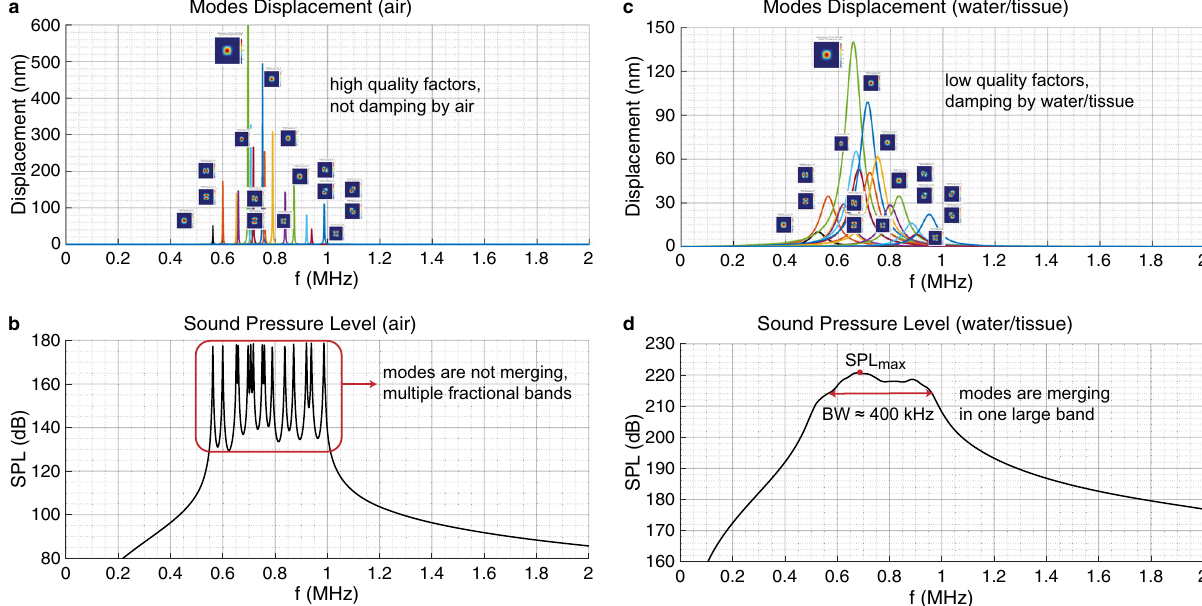
Fig. 7 Modes merging in air vs water/tissue. a LN pMUT 3D membrane displacement measurement and peak detection in air. Modes are matched to COMSOL Multiphysics simulation based on their shape. Here we notice that the peaks are separated from each other due to a high-quality factor in air. The different colors represent different modes extracted from the measurement in air from Fig. 2a. b Simulated combined sound pressure level (SPL) of the device in air. Here we can notice that the different peaks are not merging, instead we have the formation of multiple fractional bands. c Displacement modeling of the resonance peaks under the damping effect of the water and tissue medium. Here the quality factor is getting lower and closer to one another. The different colors represent different modes extracted from the measurement in air from Fig. 2a and then modeled under the damping effect of the water, by decreasing the quality factor. d Modeling of the computed output SPL resulting in a uni fi ed large band of BW ≈ 400 kHz, matching very closely with the reference hydrophone